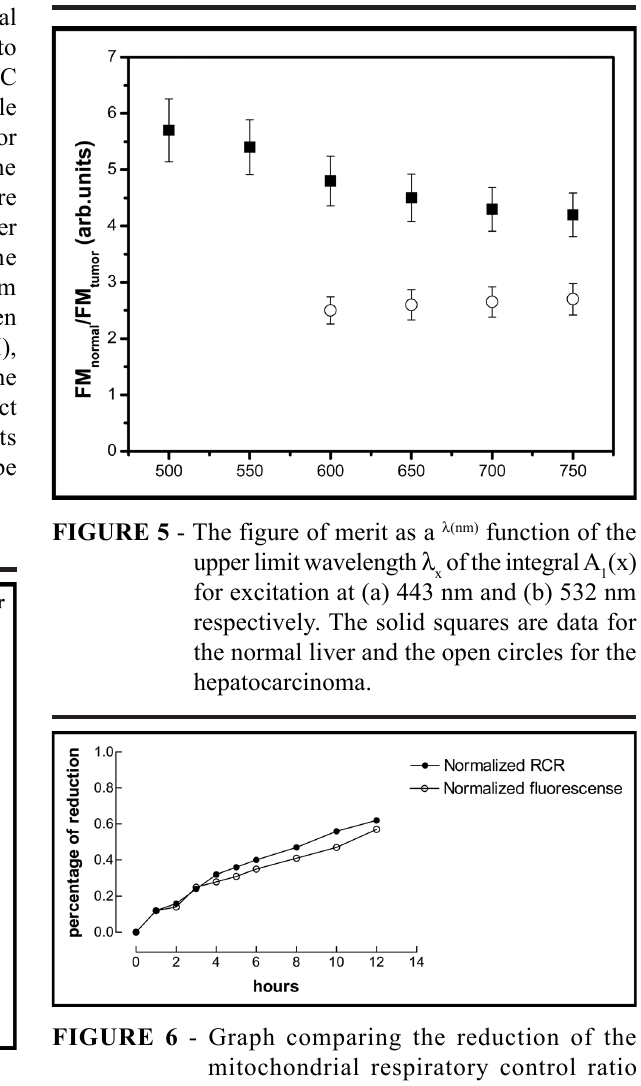
FIGURE 3 - Schematic diagram of the fluorescence spectroscopy system.